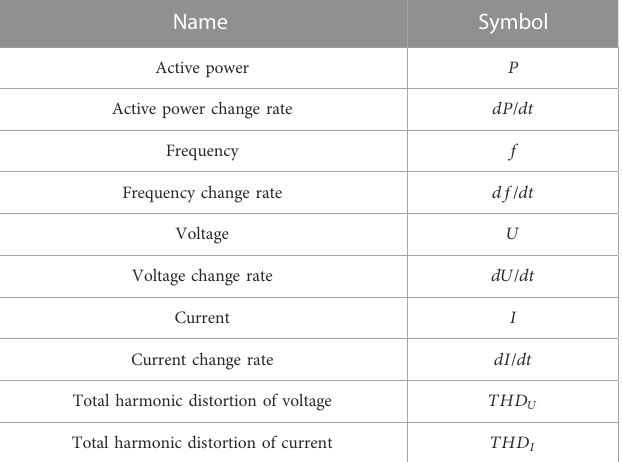
TABLE 1 Multiple electrical feature quantities at PCC.